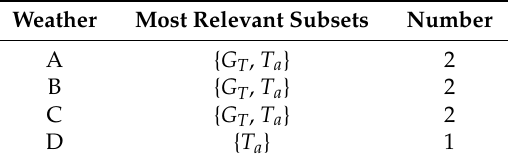
Table 6. The most relevant subsets in four